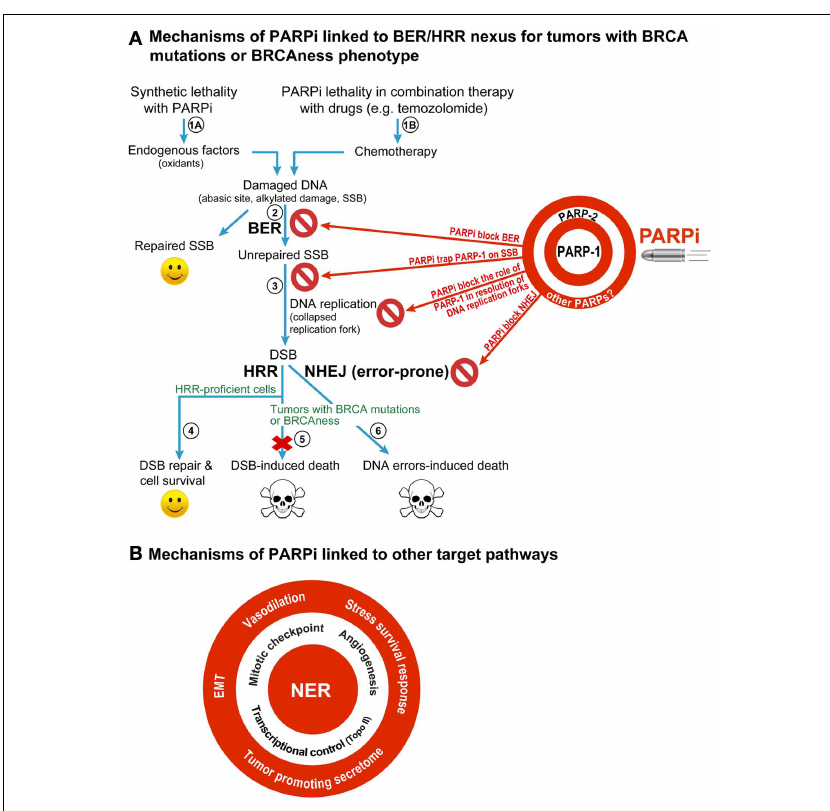
FIGURE 1 | Different mechanisms for therapeutic efficacy of PARPi in cancers . (A) BER/HRR model: this model focuses on the role of PARP-1, the principal target of PARPi, in BER that removes abasic sites and SSB created constantly in the mammalian genome by endogenous oxidants (steps 1A). During BER, the binding of PARP-1 to SSB leads to stimulation of its catalytic activity of forming polymers of ADP-ribose (PAR) from its substrate NAD + .The PAR and PARP-1 interact with and recruit the key BER scaffold protein XRCC1, whereas PAR-modified PARP-1 loses its affinity to bind to SSB and vacates the site for BER to continue.When PARPi suppress the role of PARP-1 in BER (step 2), the unrepaired SSB would accumulate and collapse the DNA replication fork to form potentially lethal DSB (step 3).The normal cells would survive by repairing these DSB by HRR (step 4), but the HRR-deficient BRCA-mutants would die due to unrepaired DSB (step 5) or possibly due to excessive reliance on the error-prone NHEJ repair pathway to remove DSB (step 6).This BER/HRR nexus also explains the effectiveness of combination therapy of PARPi with drugs that cause DNA damage that is repaired by BER (step 1B). Since PARP-2 is also known to play a role in BER, and since current PARPi are also known to inhibit PARP-2, the effect of PARPi may also be mediated by targeting of the functions of PARP-2 in BER, as shown on the target board along with PARP-1. In addition, the inhibitory effect of PARPi on other PARPs could also influence therapeutic efficacy of PARPi (see target board), although their contribution to BER/HRR mediated therapeutic effect of PARPi is not yet fully assessed. (B) Other targets of PARPi that can confer therapeutic benefits of PARPi: PARPi could also be effective anticancer agents by targeting the role of PARP-1 in other DNA repair pathways, such as NER; or other cellular pathways, such as control over cell cycle, tumor angiogenesis, transcription, epithelial-mesenchymal transition (EMT), stress survival response, vasodilation, or tumor-promoting